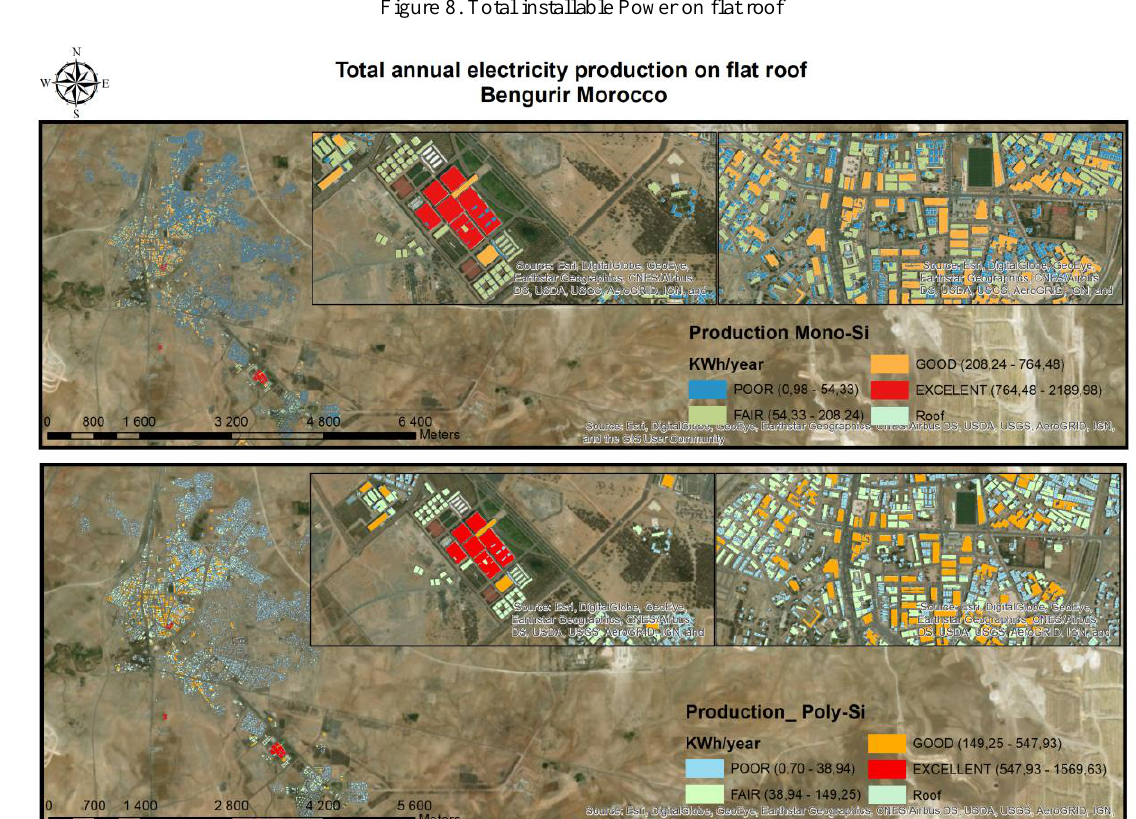
Figure 9. Total annual electricity production on flat roof